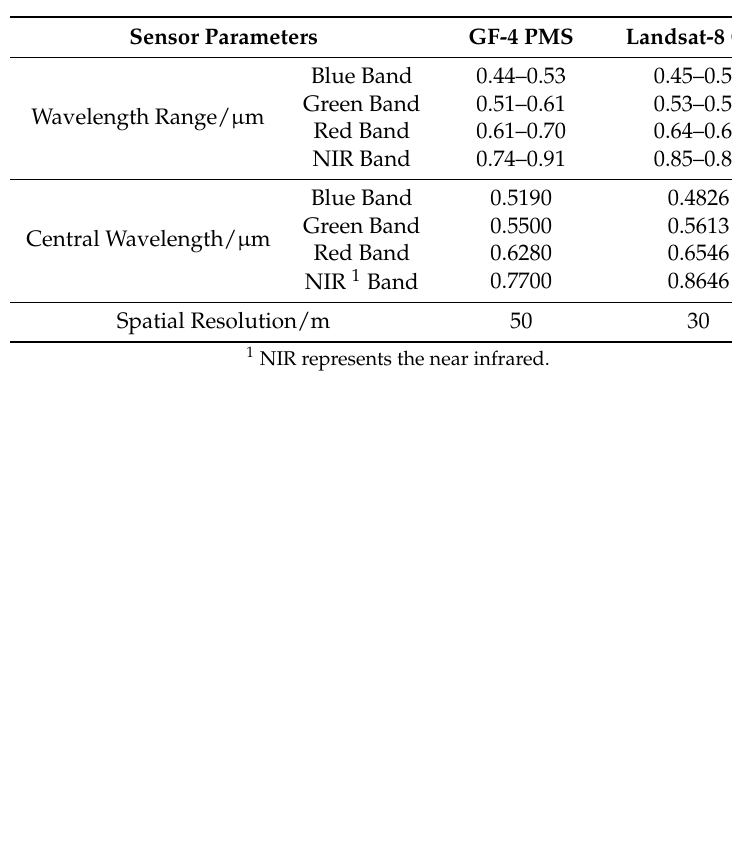
Table 1. Sensor parameters of the Gaofen-4 panchromatic and multispectral sensor (GF-4 PMS) and Landsat-8